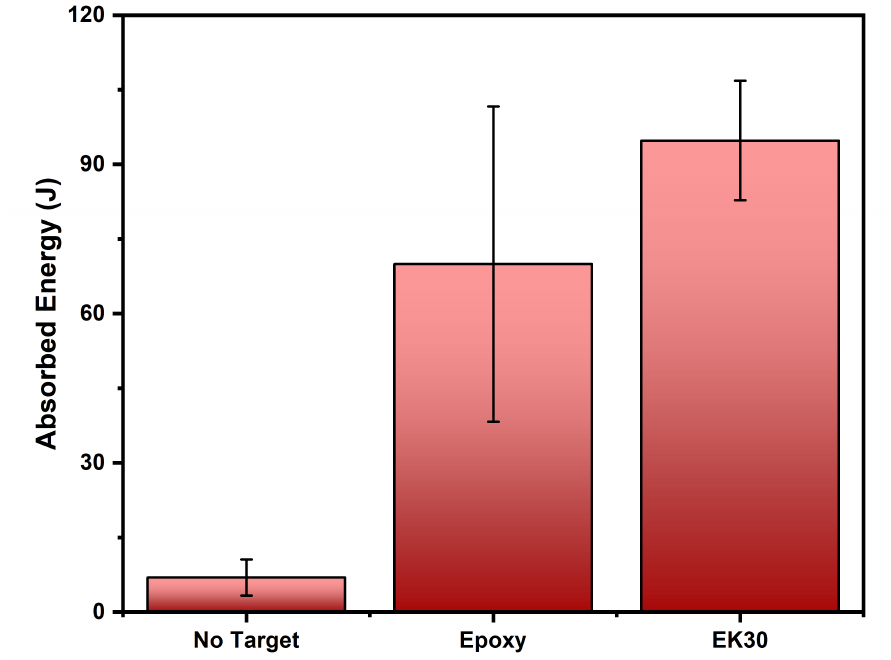
Figure 8. Values of ballistic absorbed energy against 0.22 caliber ammunition of plain epoxy, 30 vol% kenaf fiber composite and shooting condition without actual